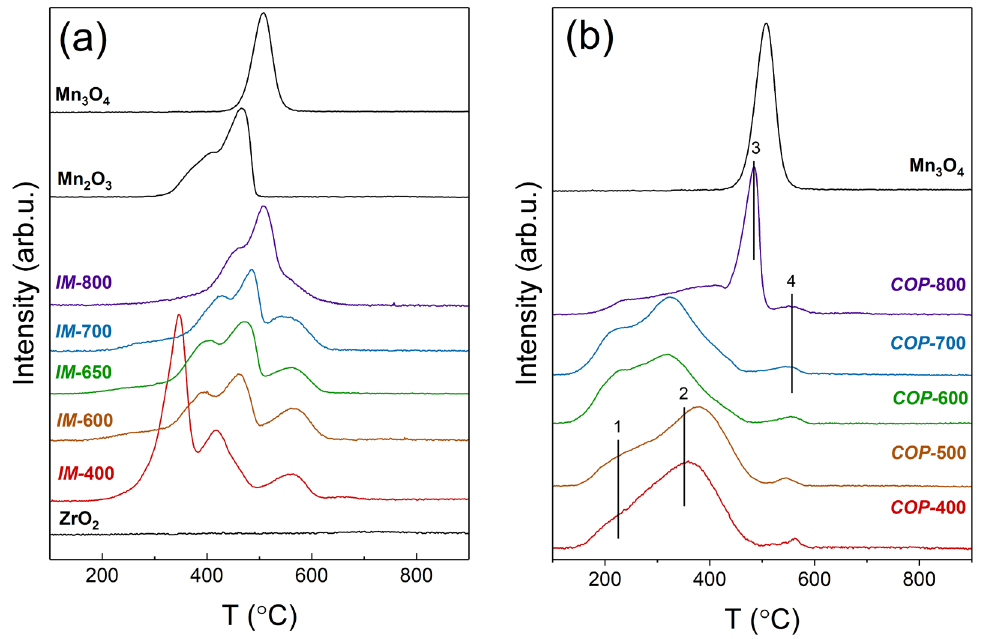
Figure 6. TPR curves of the IM ( a ) and COP ( b ) catalysts, with ZrO 2 , Mn 3 O 4 , and Mn 2 O 3 as references.